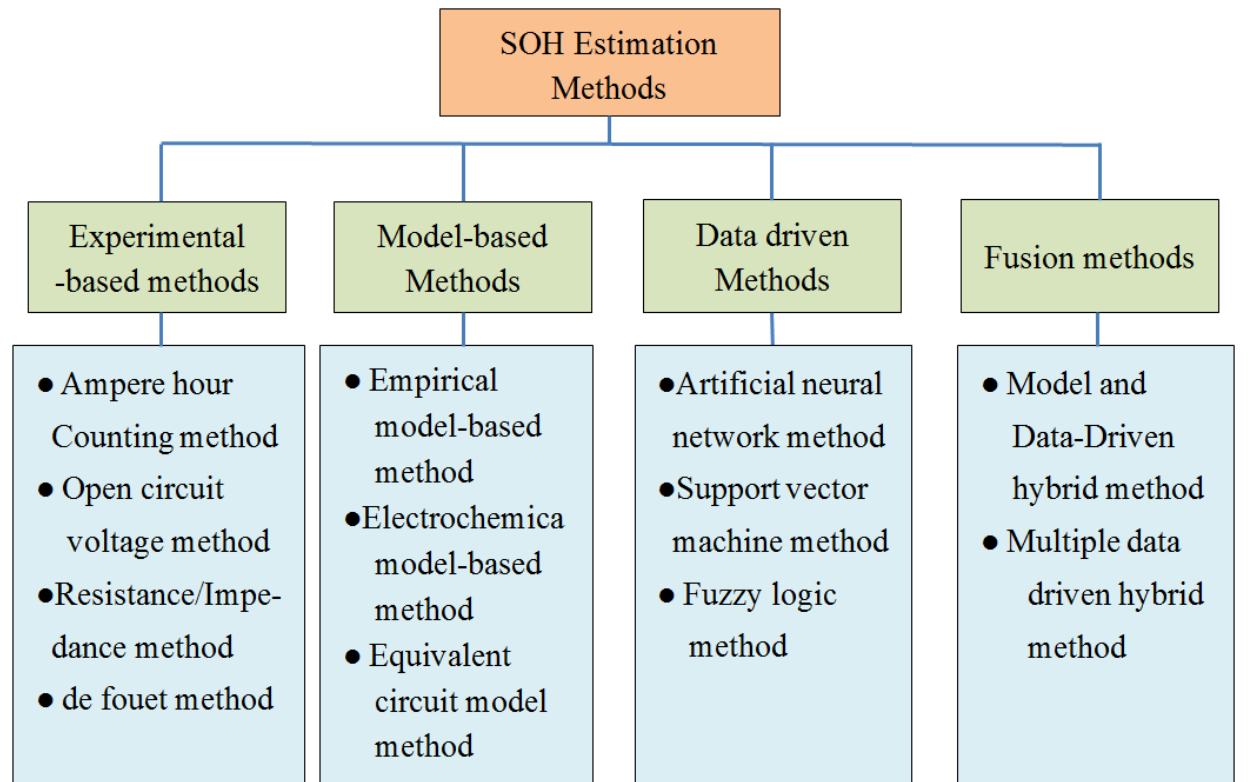
Figure 2. State of health (SOH) estimation methods.